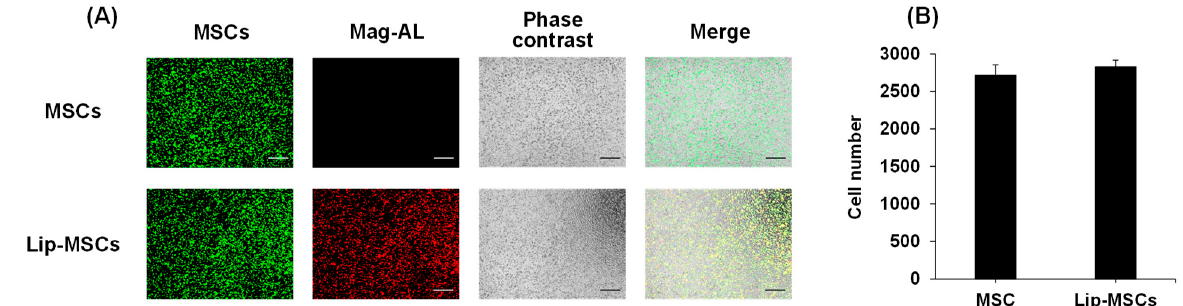
Figure 5. In vitro adhesion of Lip-MSCs to HUVECs monolayer. Non-loaded MSCs or Lip-MSCs were added to HUVECs monolayer cultured in 24-well culture plates, and incubated for 1 h at 37 °C. ( A ) Representative photographs of non-loaded MSCs or Lip-MSCs adhered to HUVECs mono- layer. Scale bar: 500 µm. ( B ) The number of non-loaded MSCs or Lip-MSCs adhered to HUVECs monolayer. Each value represents the mean + SD ( n = 3).